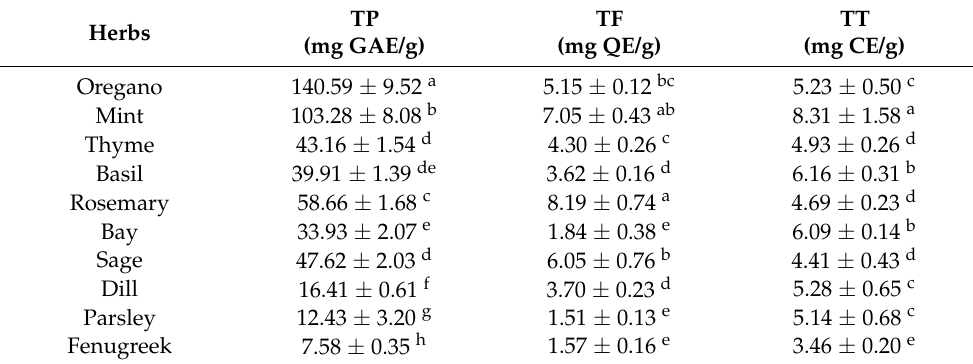
Table 1. Total phenolic content, total flavonoids and total tannins of 10 widely used herbs.